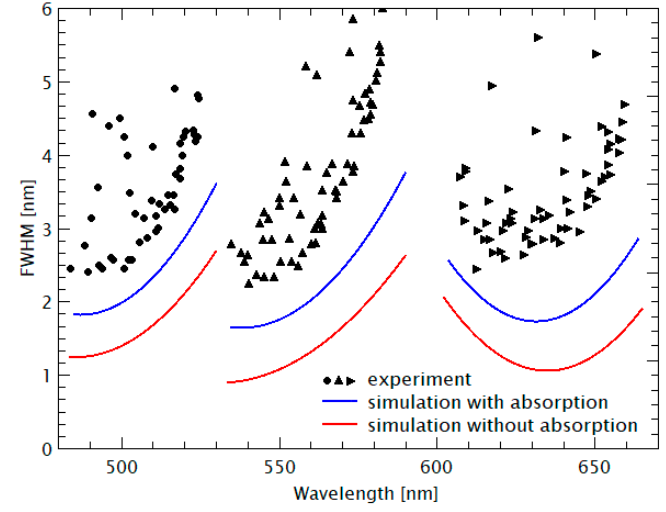
Figure 6. Comparison of measured FWHM (symbols) and simulated FWHM (full lines) of a FP filter array including three stopbands for the visible spectral range which are intentionally shifted compared to Figure 5. The corresponding Transfer Matrix simulations include experimental data for spectral absorption and spectral dispersion. The symbols correspond to experimental data, while the full lines correspond to Transfer Matrix model simulations with consideration of the experimental data from spectroscopic ellipsometry. The blue (red) is calculated with (without) spectral absorption. For SiO 2 , the material refractive index n ranges from 1.4505 (480 nm) to 1.4363 (660 nm) and the absorption coefficient α ranges from 22.30 cm − 1 (480 nm) to 11.04 cm − 1 (660 nm). For Si 3 N 4 , the material refractive index n ranges from 1.8328 (480 nm) to 1.8029 (660 nm) and the absorption coefficient α ranges from 250.39 cm –1 (480 nm) to 122.50 cm − 1 (660 nm). Material dispersion for the resist is considered; the material refractive index n ranges from 1.5391 (480 nm) to 1.5266 (660